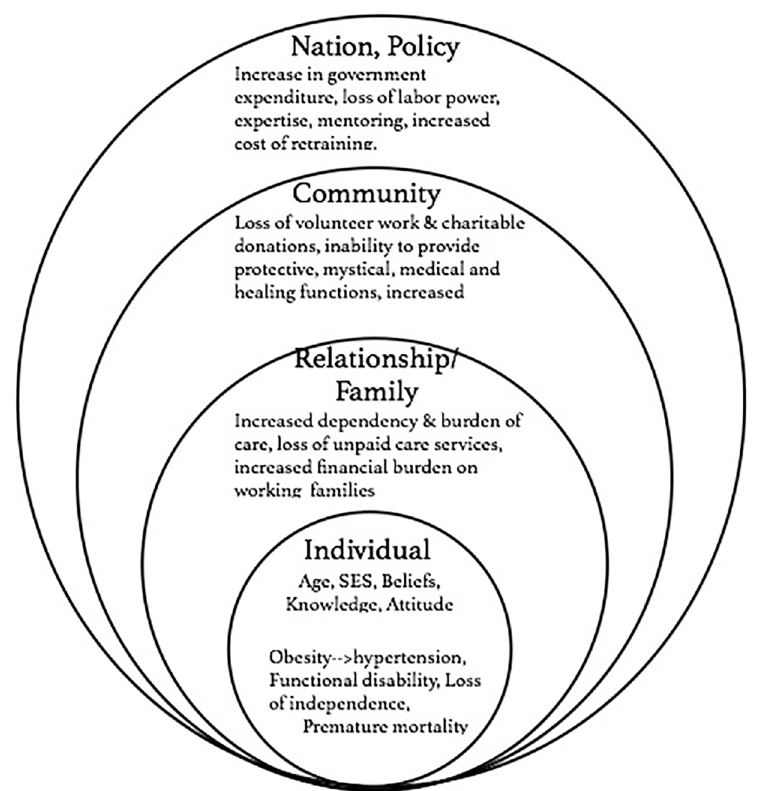
Fig 1. The ecological model: A framework for understanding the effectsof health risks among the elderly.